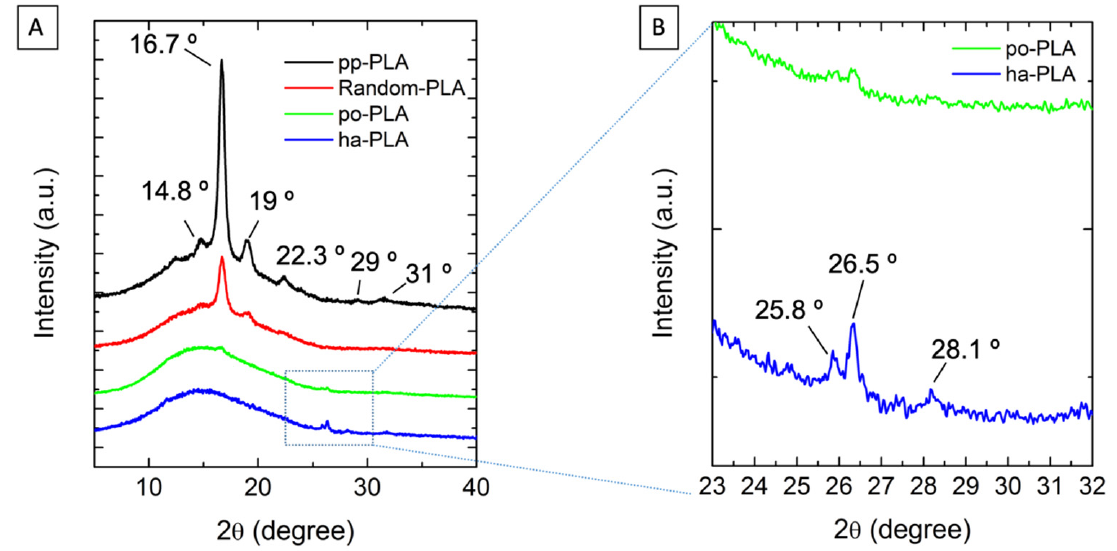
Figure 7. ( A ) X ray diffractograms corresponding to pp-PLA, random-PLA, po-PLA and ha-PLA (highly oriented) fibers. ( B ) Inset of the scale (2 θ = 23 to 32°) corresponding to PLA β -form related region.